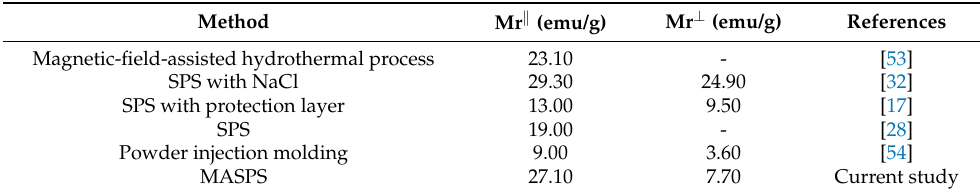
Table 13. Mr (cid:107) and Mr ⊥ values of sintered BaFe 12 O 19 with different methods. Method Mr (cid:107) (emu/g) Mr ⊥